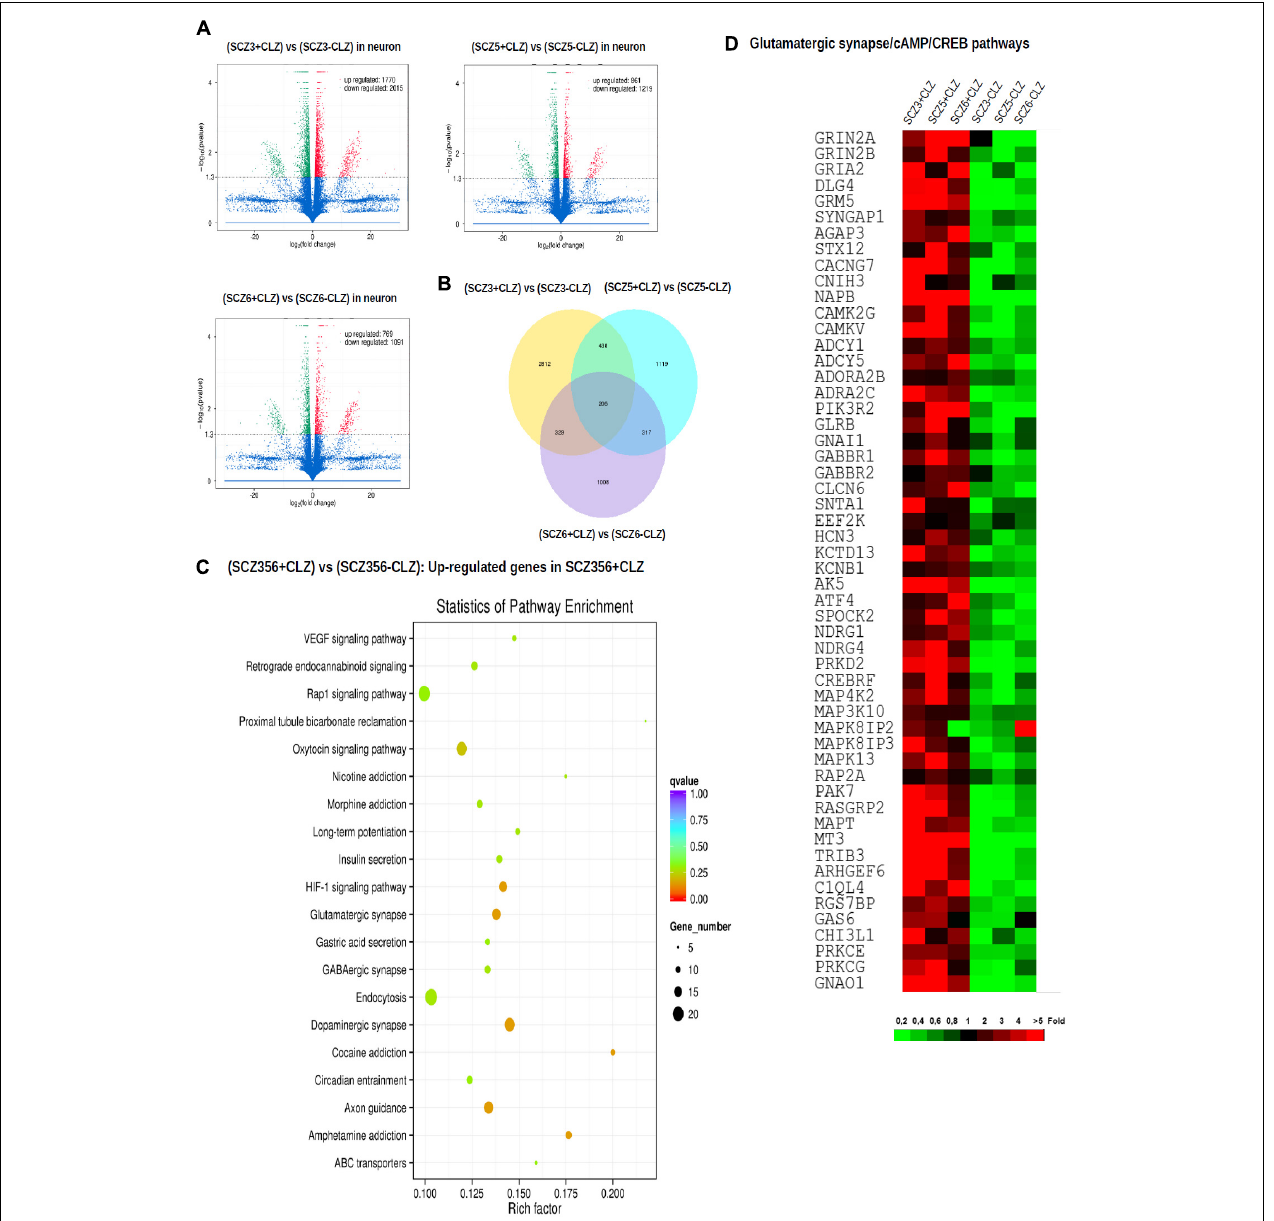
FIGURE 6 | Gene expression after clozapine pretreatment. The results of transcriptomic profiling. (A) Volcano plots comparing the number of differentially expressed genes in individual clozapine responsive patients. (B) The number of genes with different expression profile in individual clozapine responsive patients. (C) Pathway enrichment analysis showing up-regulated genes after clozapine pretreatment. (D) Gene expression of glutamatergic, CREB, and cAMP pathways in cells from individual clozapine responsive patients before and after clozapine pretreatment. The magnitude of the expression is